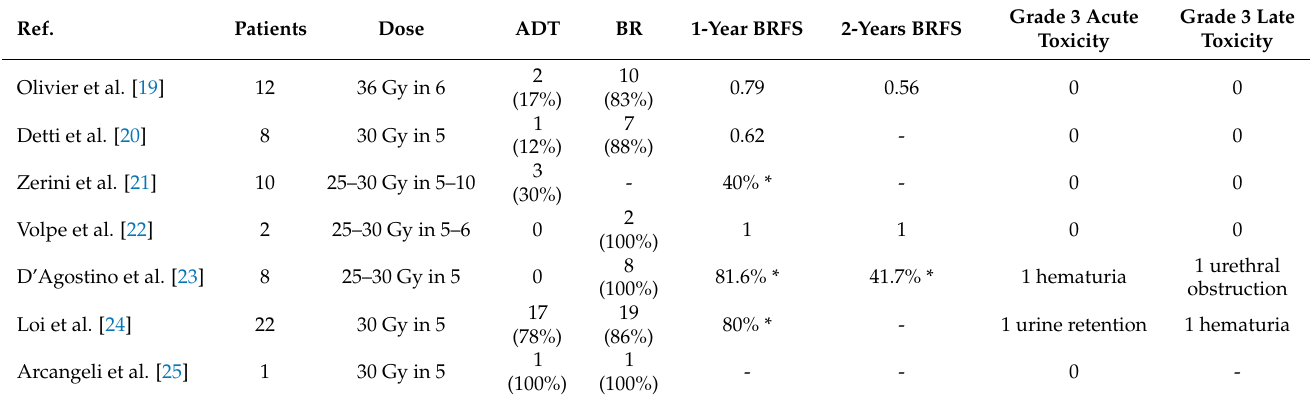
Table 6. Re-irradiation of prostatic bed: summary of the literature.